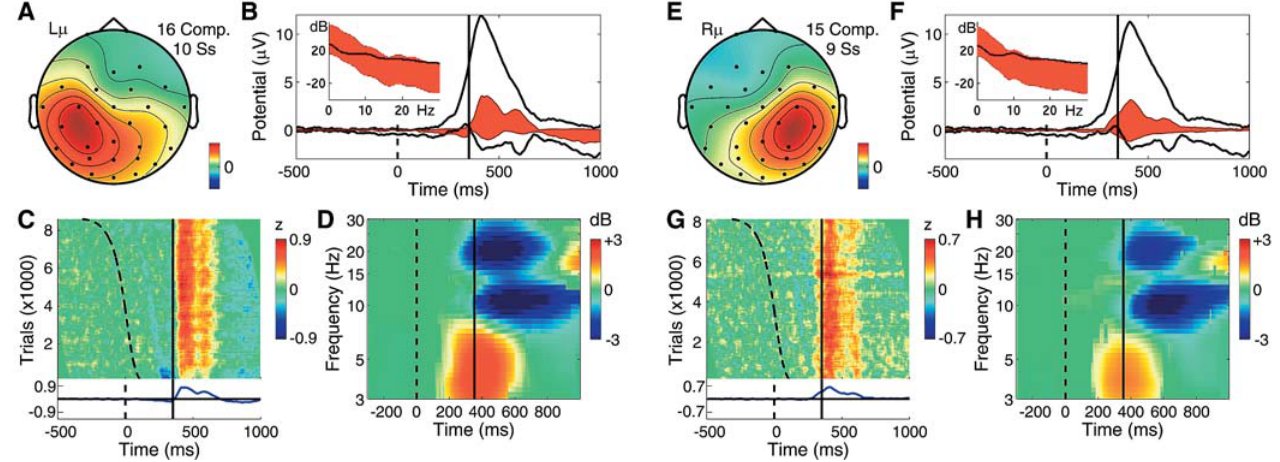
Figure 8. Two Mu Rhythm Component Clusters Also Showing the Postmotor Theta Response Pattern Panels as in Figure 6. (A–D) Left mu rhythm (L l ) component cluster with mu characteristic 10-Hz and 22-Hz peaks in the activity spectrum. (D) Following the button press, this activity is blocked. (E–H) Corresponding right mu rhythm (R l ) component cluster. DOI: